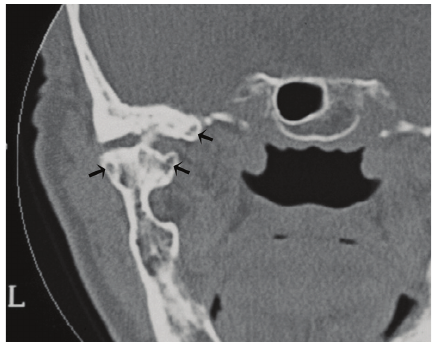
Figure 3: Subchondral cysts called Ely’s cysts (arrows).